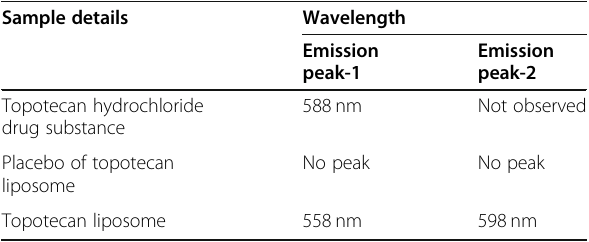
Table 3 Observation of fluorescence study for drug